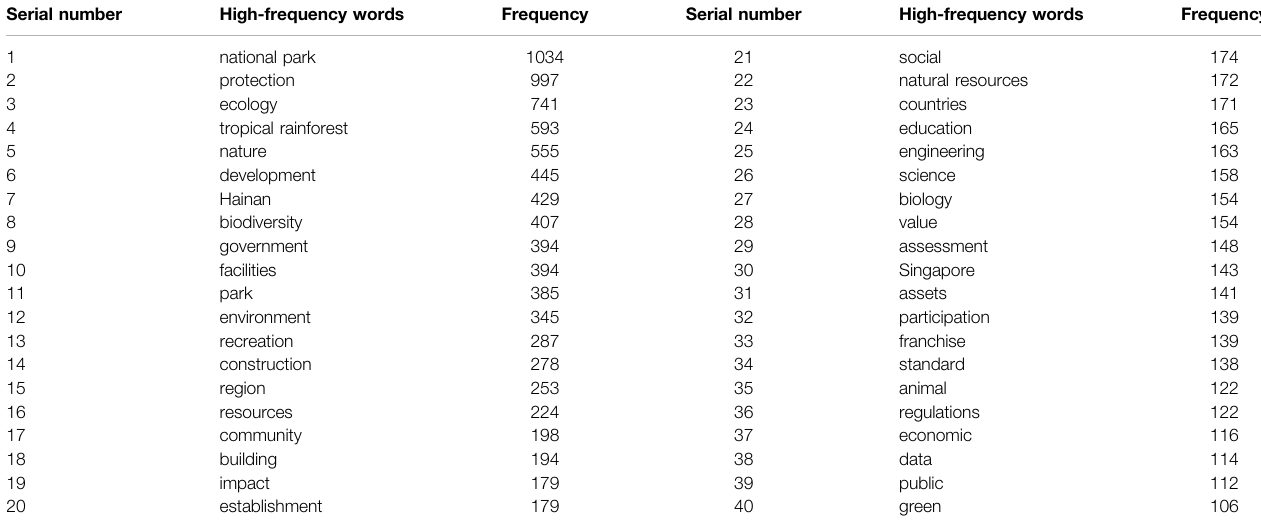
TABLE 2 | Statistics of high frequency words in National Park policy.